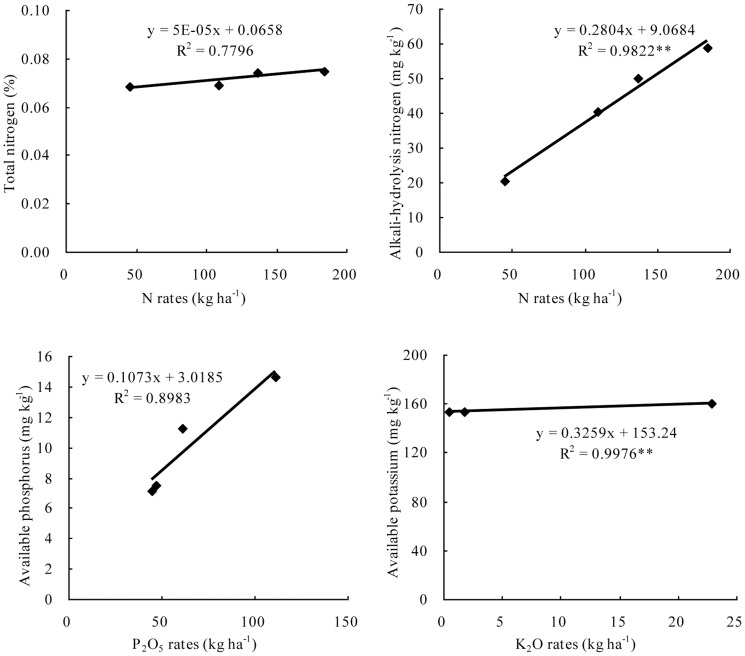
Relationships between N rates and total nitrogen, N rates and alkali-hydrolysis nitrogen, P2O5 rates and available phosphorus and K2O rates and available potassium on wheat plots in the Weibei region of Shaanxi province.**Significance level: P<0.01.